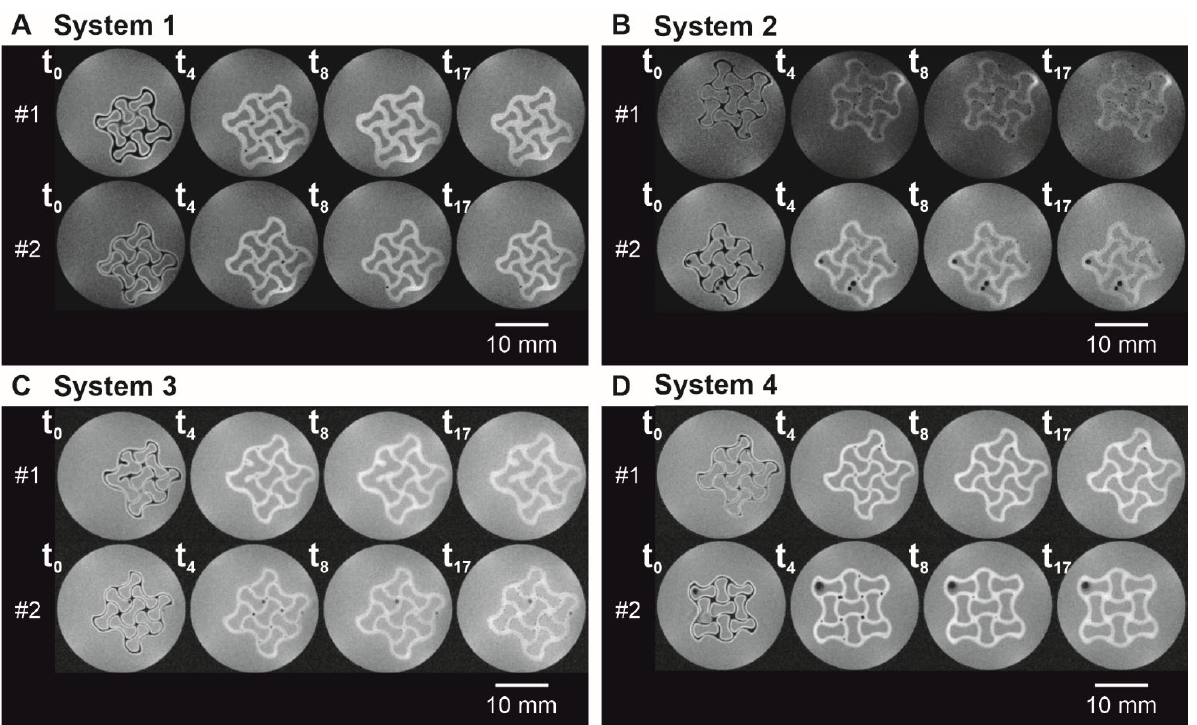
Figure 2. Auxetic structures in different liquid phases in MRI grayscale images with a field of view of 25 × 25 mm² at distinct time points. The liquid phase was ( A ) System 1, ( B ) System 2, ( C ) System 3, and ( D ) System 4 ( n = 2).